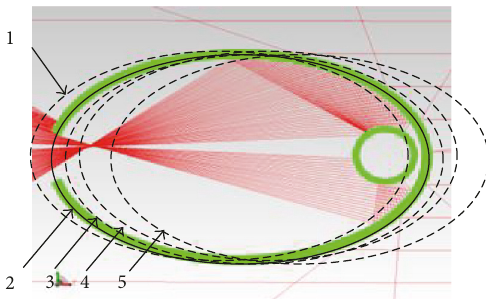
Figure 5: Elliptical cavity under di ff erent PTC focal lengths when α =0.2 °